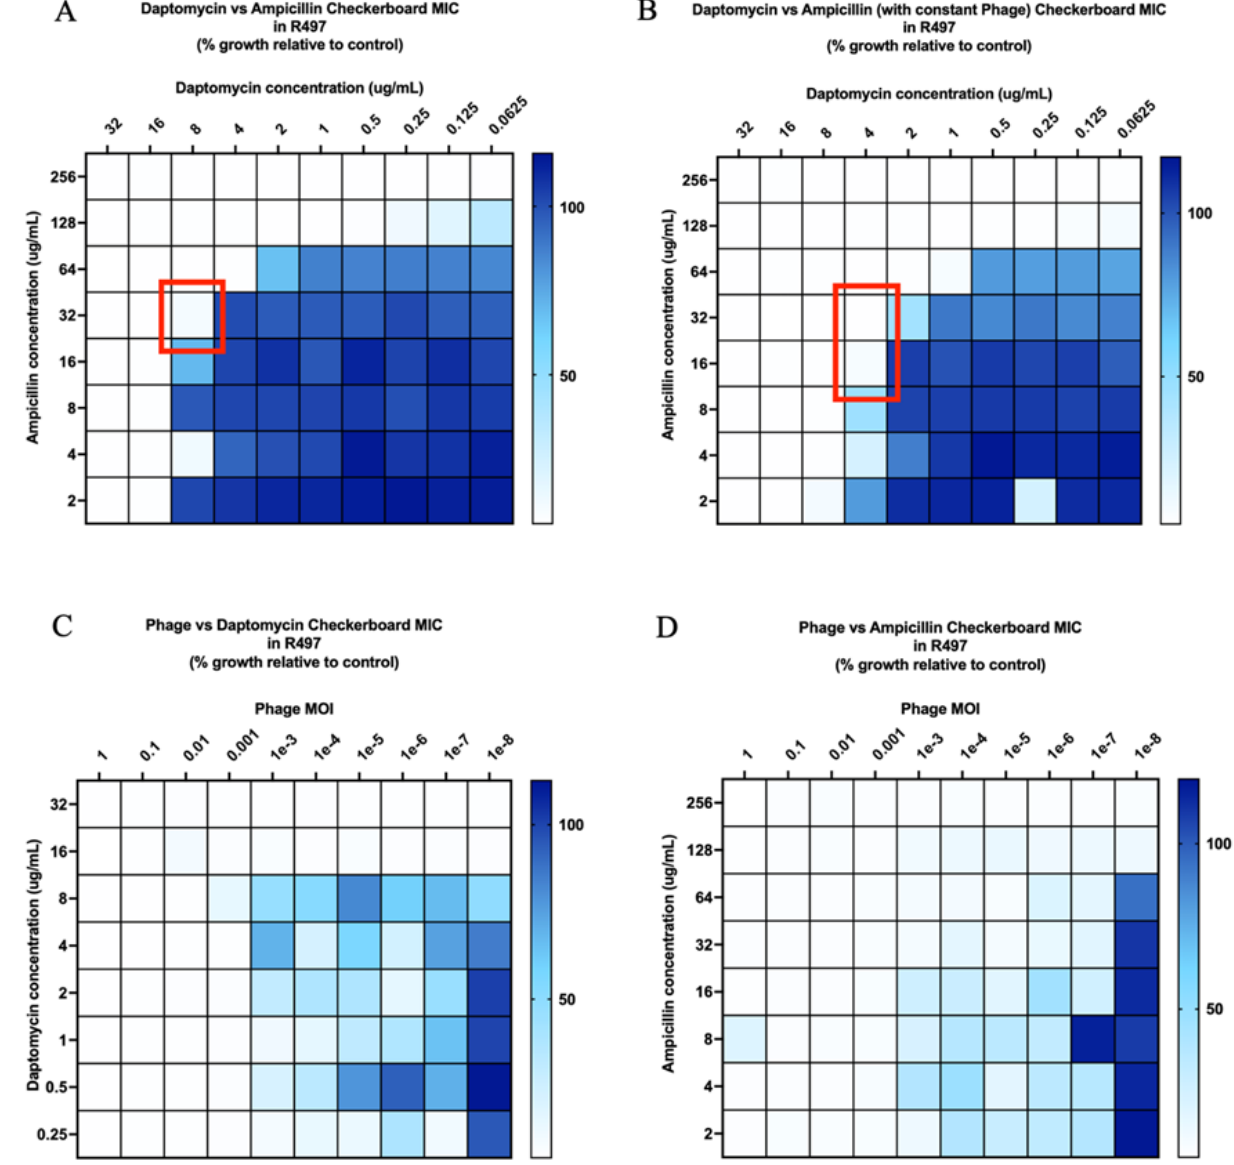
Figure 1. ( A – D ) Checkerboard analysis of E. faecium strain R497. Additivity, defined as an FIC index >0.5 but <4, is indicated by the red outline in ( A ). Synergy, defined as an FIC index ≤ 0.5, is indicated by the red outline in ( B ). Comparisons are versus growth control and depicted by the blue color gradient as percentage of growth.